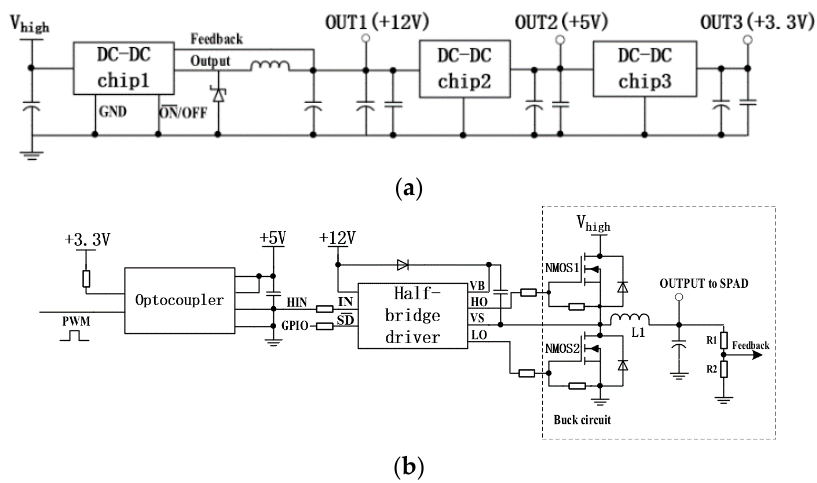
Figure 2. Schematic of the ( a ) power management and ( b ) bias circuit.